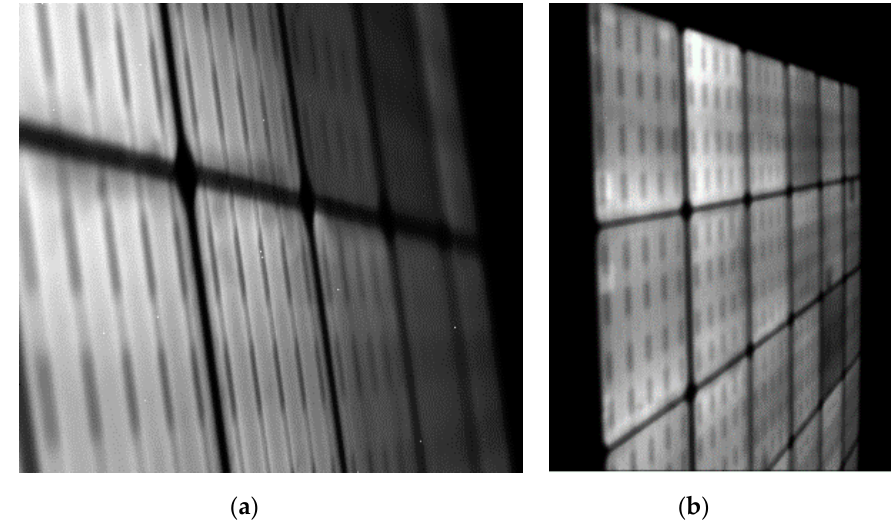
Figure 9. Electroluminescence images obtained at small incidence shooting for: ( a ) Terracotta; and ( b ) Texturing roof Tile.